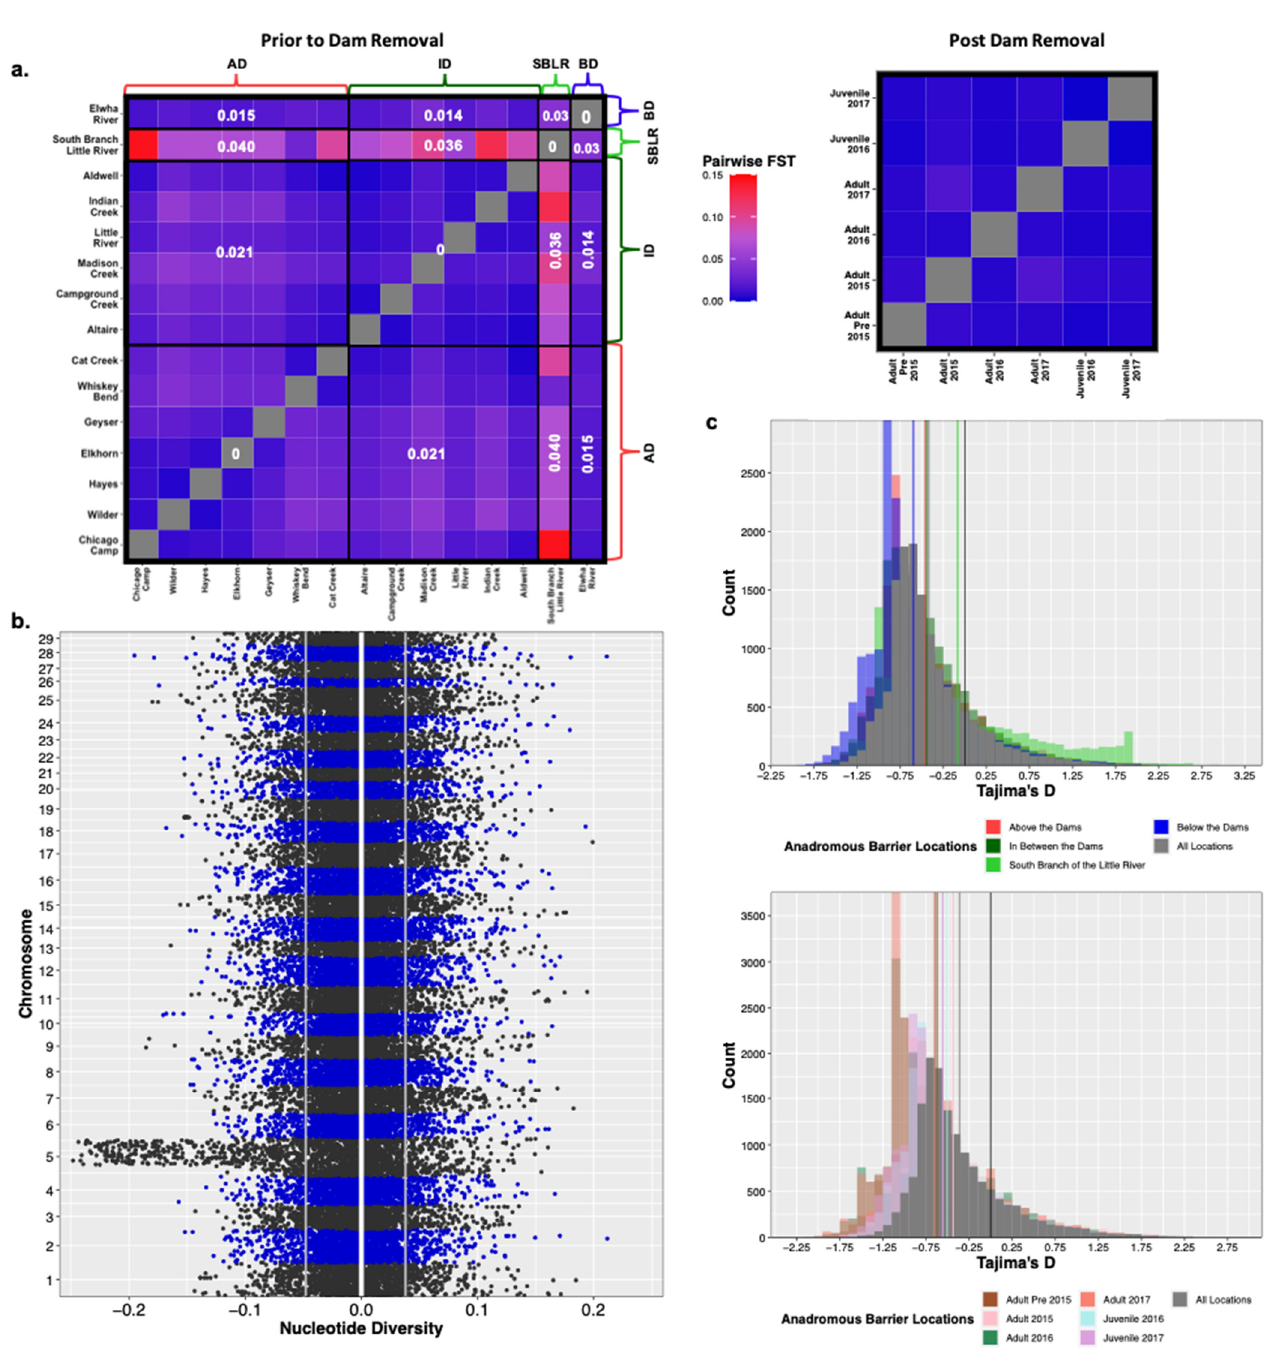
Figure 4. Prior to dam removal we saw genetic differentiation (FST) among populations separated by anadromous barriers, but little temporal differentiation among life history cohorts sampled post-dam removal ( a ). We saw a significant increase in nucleotide diversity ( π ) at Omy5 post-dam removal, but not genome wide ( b ). The white vertical line is at zero, the two grey lines represent the upper and lower bounds of bootstrapped confidence intervals. There were statistically insignificant increases in estimates of Tajima’s D temporally and among life history cohorts sampled post-dam removal ( c ).